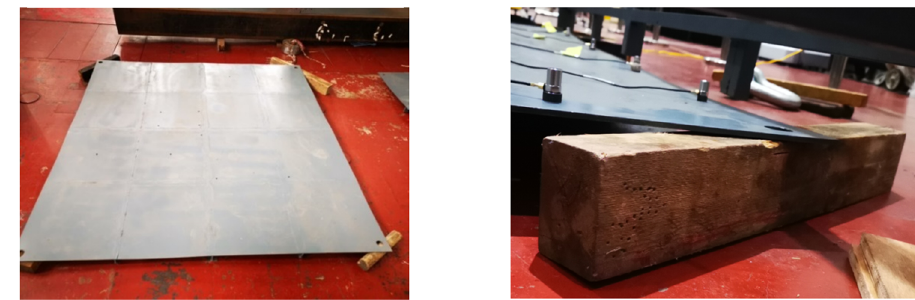
Figure 5: Simulation of simple boundary conditions.